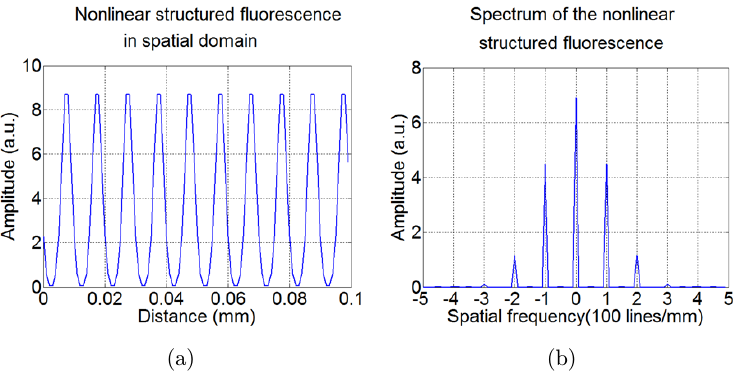
Fig. 7. Harmonic frequencies deduced by the structured illumination in nonlinear